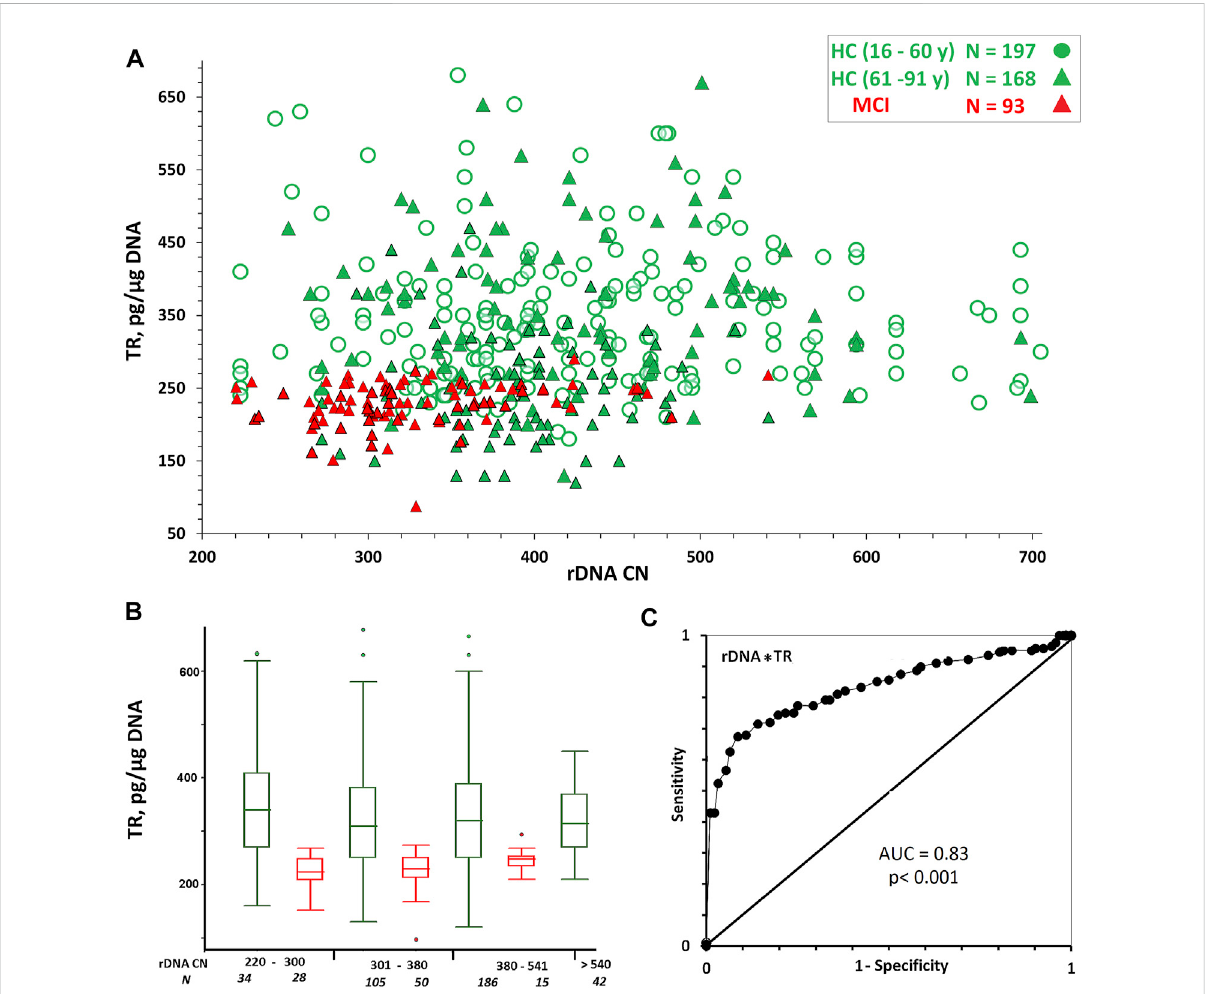
FIGURE 3 (A) DependenceofTRcontentinDNAonrDNACN. (B) AboxplotshowingtheTRcontentdistributionforeachgroup.Thegroupsweredivided into smaller subgroups, about 60 – 80 rDNA CN apart. (C) ROC curve for the HC (61 – 91y) and MCI groups. Parameters P (rDNA*TR) was